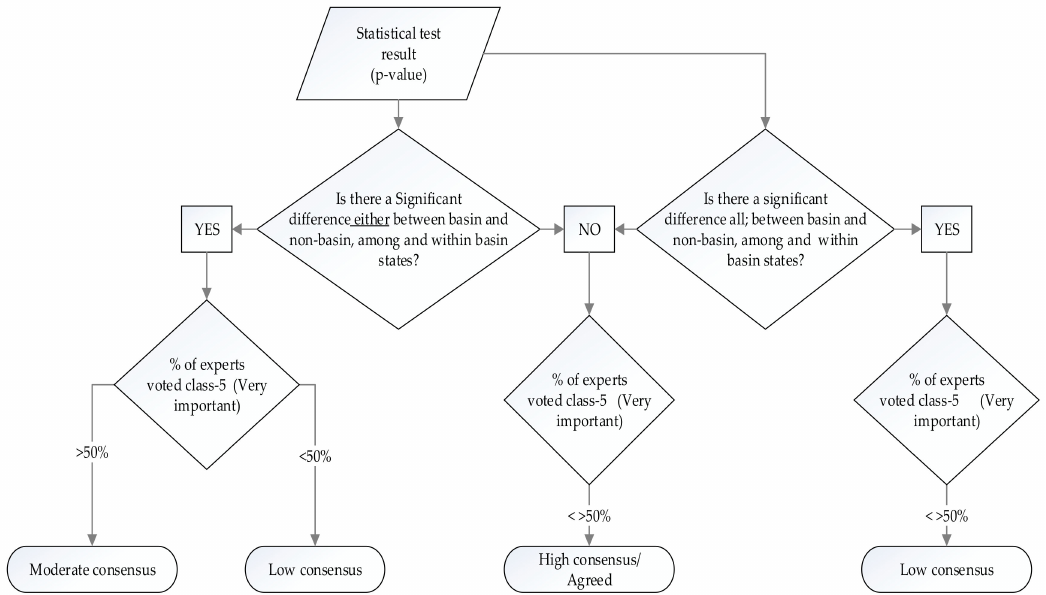
Figure 4. Flowchart for identifying the consensus level for each